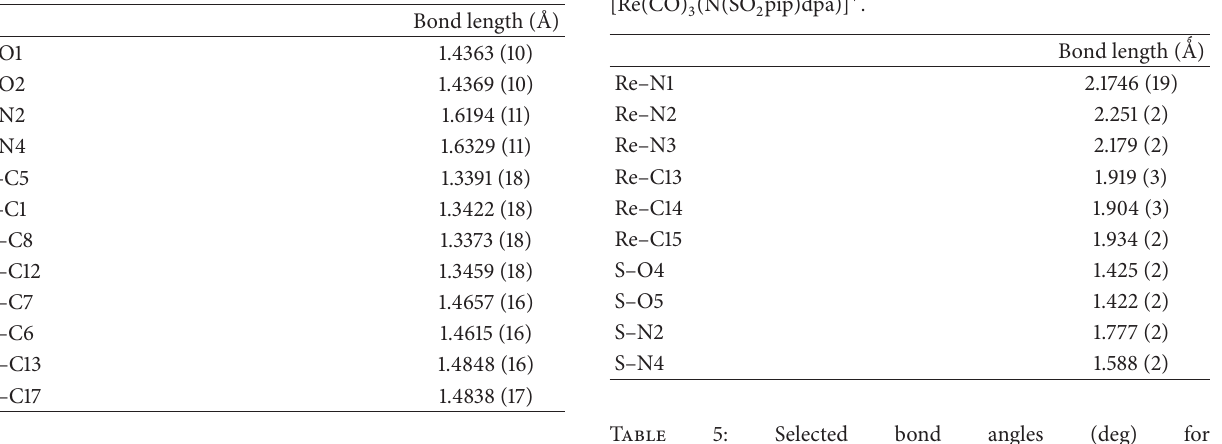
Table 3: Selected bond angles (deg) for N(SO 2